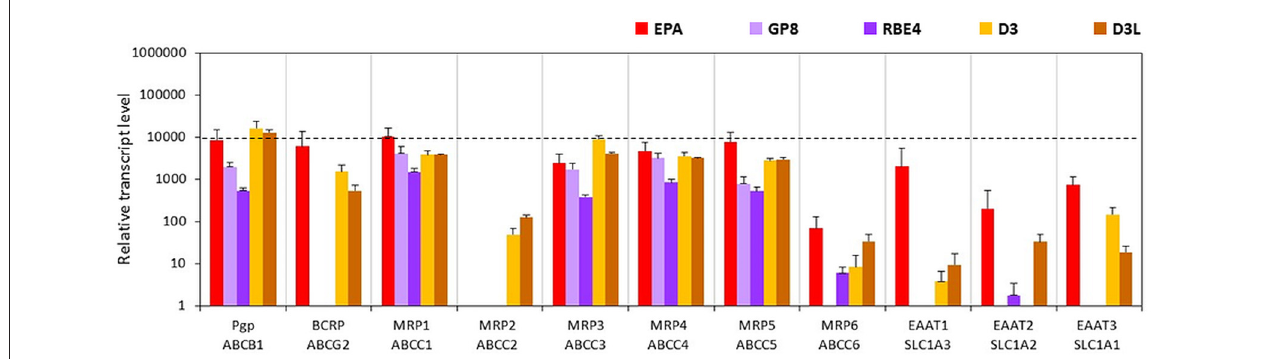
Frontiers in Molecular Neuroscience |